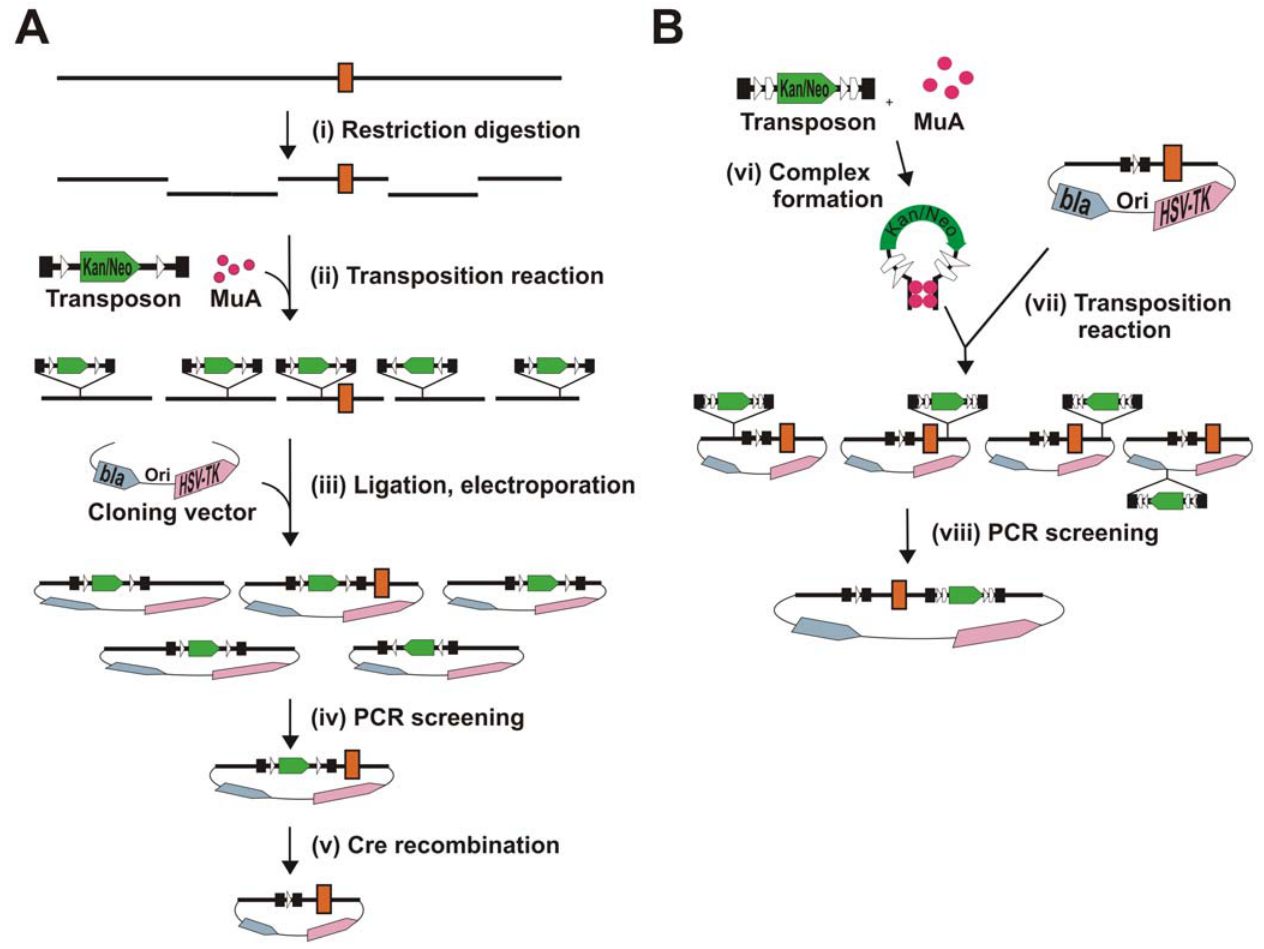
Figure 2. Flowchart for the construction of conditional knockout vectors. Part A. (i) an entire BAC clone is initially digested with an appropriate restriction endonuclease, and (ii) the ensuing fragment pool is then used as a target for the first transposition reaction. (iii) The fragment pool is subsequently ligated into a suitable vector plasmid, and those clones that include transposon-containing BAC fragments are selected using both the transposon marker and vector marker. Next, (iv) a plasmid clone that contains a transposon insertion in a desired location is identified by a PCR screen with appropriate primers, one transposon specific and the other target specific. (v) The chosen plasmid is then introduced into an E. coli strain that expresses Cre recombinase. The selectable marker is eliminated by Cre recombination in vivo , leaving a single loxP site in the construction. Part B. The second transposition reaction (vi) using pre-assembled transposition complexes (vii) introduces into the construction a marker gene that is flanked by loxP and FRT sites. (viii) As above, a suitable clone is screened by PCR to identify a plasmid, which contains the second transposon inserted in a suitable location and orientation on the opposite side (to the first transposon) of the exon of interest. Genomic DNA is shown with a black line, and the orange rectangle denotes an exon. The transposons are shown with black bars featuring the Kan/Neo cassette (green arrow), loxP sites (white triangles), FRT sites (white pentagons), and transposon ends (black rectangles).